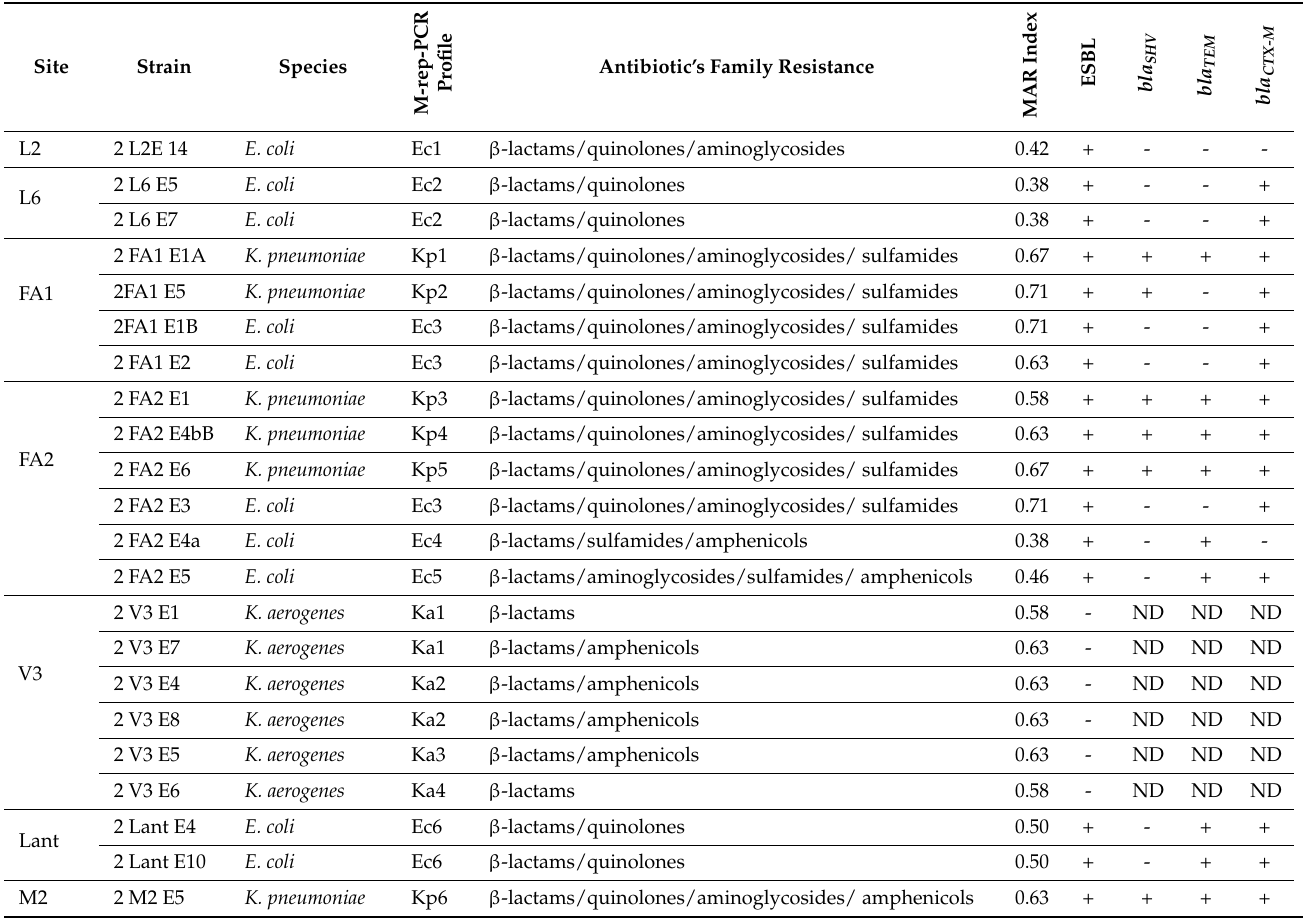
Table 1. Characterization of the Enterobacterales strains isolated during C2 campaign. Multiplex rep-PCR (M-rep PCR) profiles are numbered for each species. ESBL: extended spectrum β -lactamases production detected with the double-disc synergy test. MAR index: Multiple antibiotic resistance index. ND: not